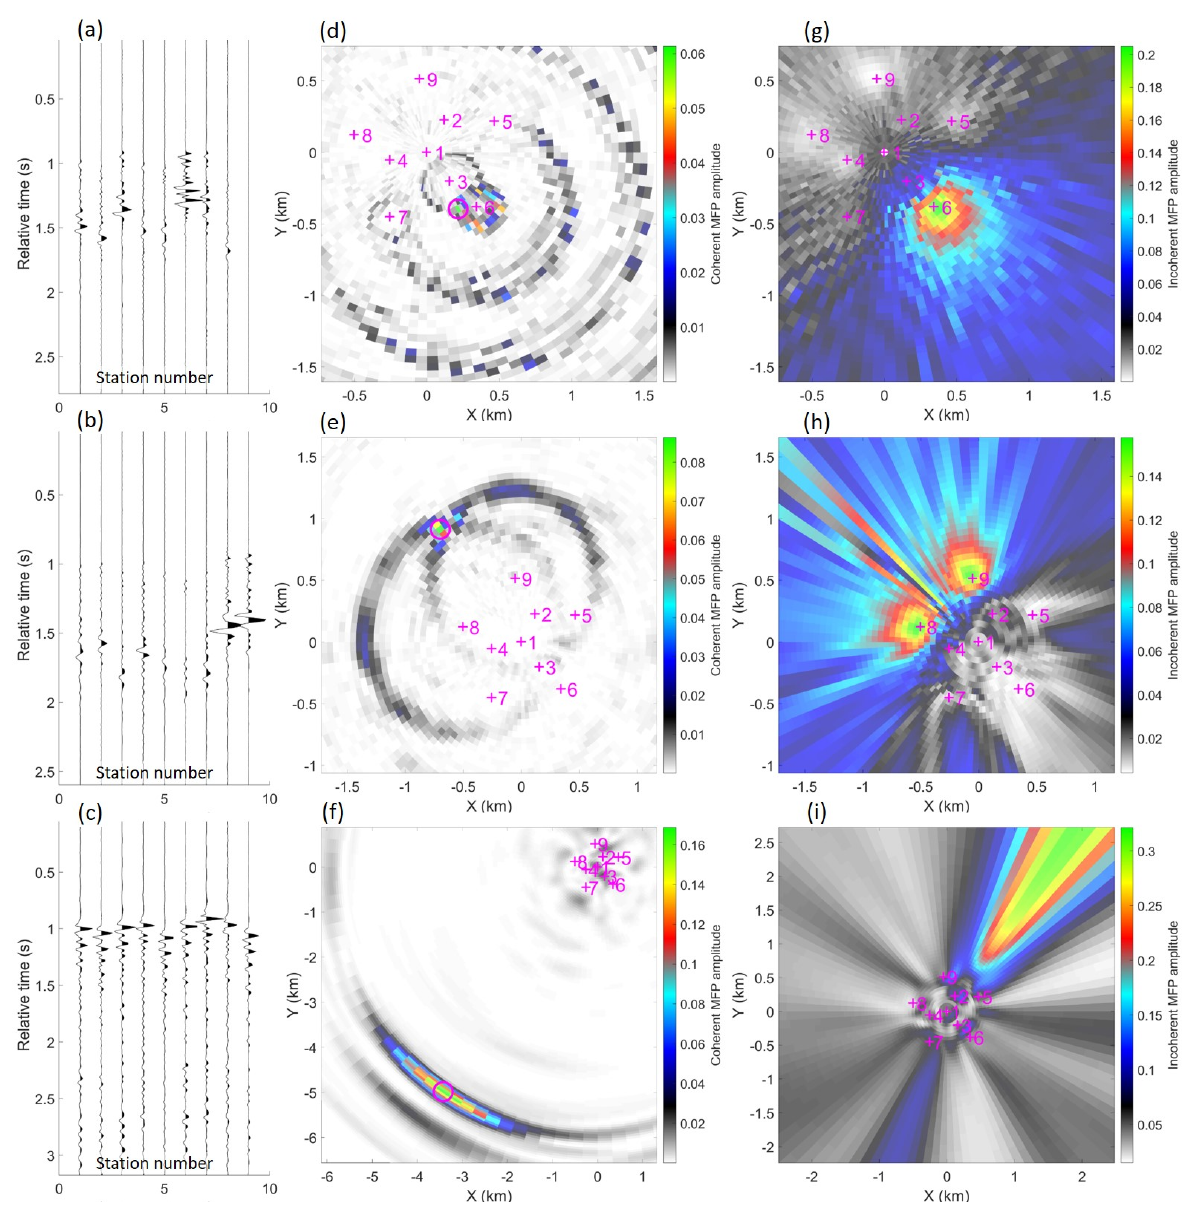
Figure 5. (a, b) Examples of class I events with significant amplitude variation across the array and relatively close source position inferred by panels (d) and (e) as coherent MFP (Eq. 7). (c) Example of a class II event with little amplitude variation across the array and a more distal (f) coherent-MFP-inferred source position. Panels (g) , (h) , and (i) show corresponding incoherent-MFP results (Eq. 4), demonstrating the improvement gained by coherent MFP. Station numbers in panels (a) , (b) , and (c) correspond to the labels annotated in the MFP panels, where the seismometer locations are marked with magenta